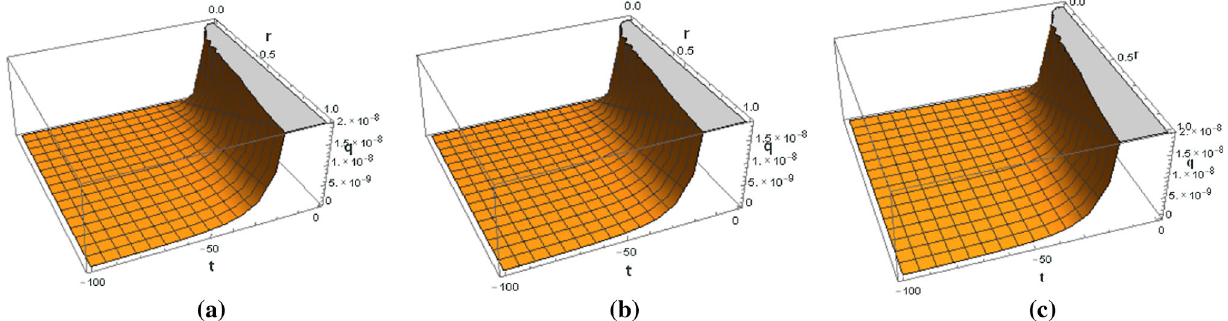
with λ = 0 . 1 & γ = 0 . 0002 respectively. For each of these f ( R ) (cid:2) (cid:3) exp ( − γ R ) − 1